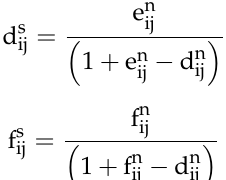
2. Normalized crisp values are computed for the left side and right side, using Equa- tions (12) and (13).